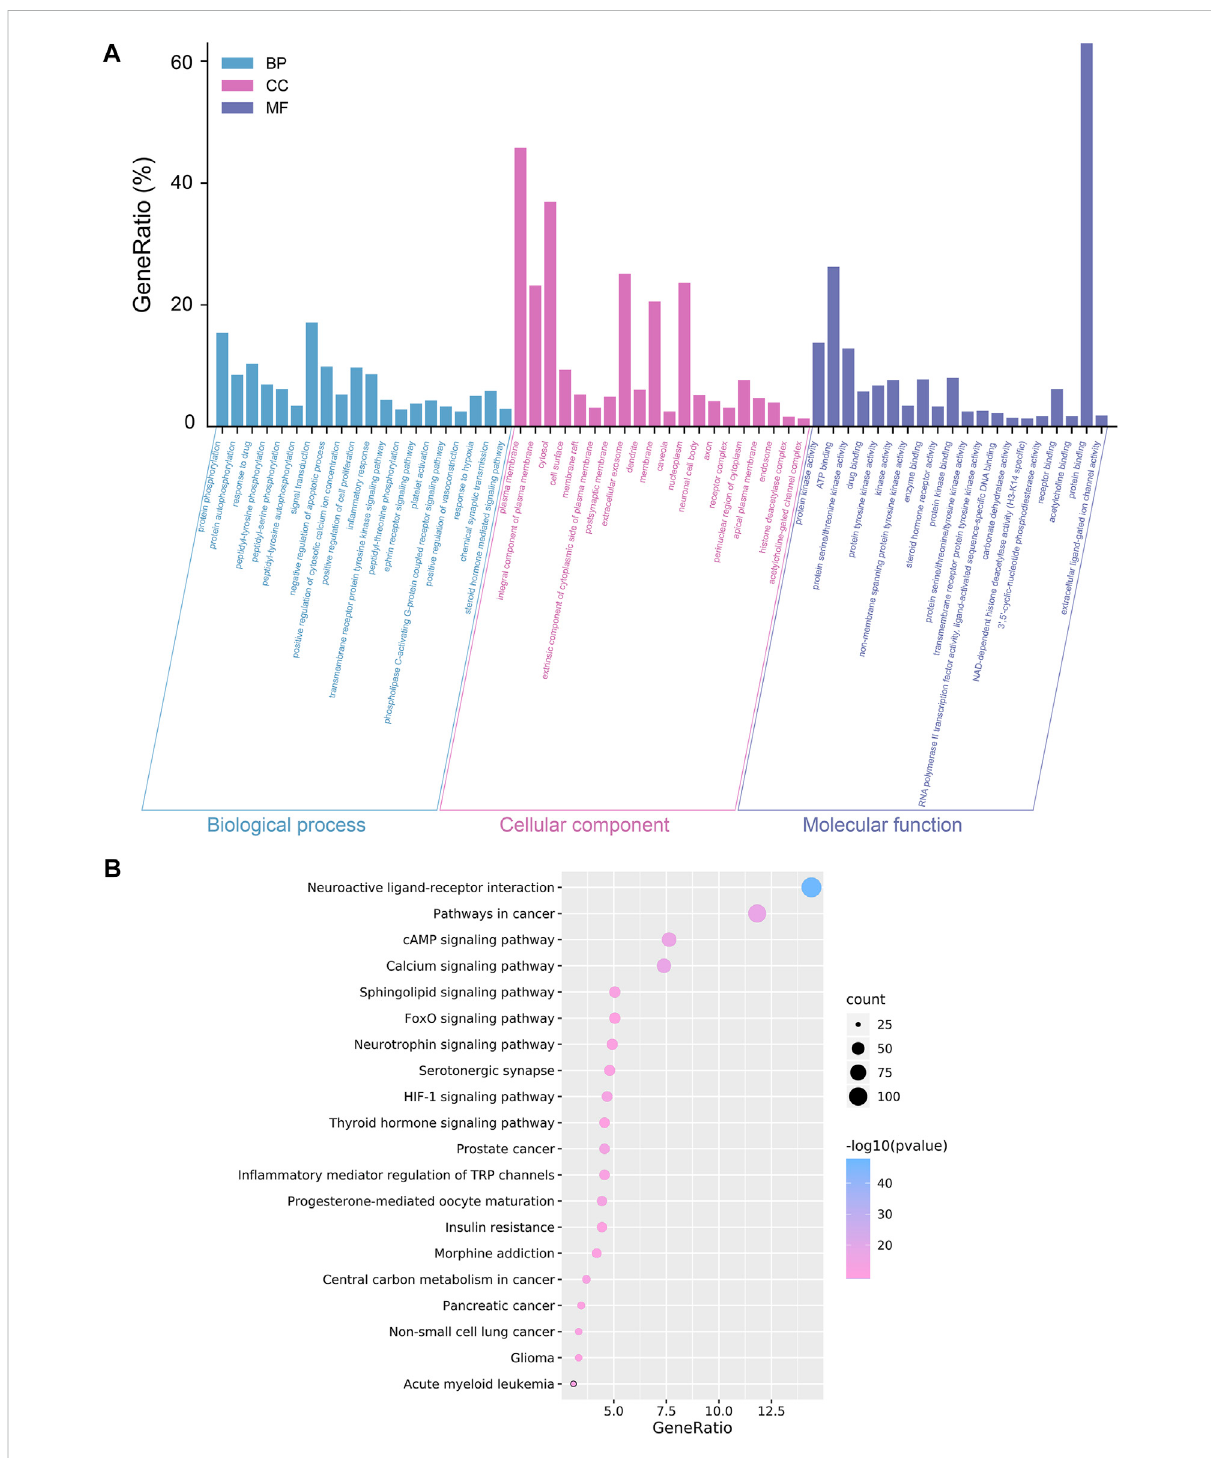
FIGURE 2 Analyses of GO and KEGG enrichment for CCMM targets ( p -value ≤ 0.05). (A) The top 20 GO enrichment terms include biological process, cellular component, and molecular function. The GeneRatio (%) of the top 20 most signi fi cant enrichments is shown in the bar graphs. (B) The top 20 KEGG pathways. The color grades re fl ect the various p -value thresholds, and the sizes of the dots indicate the number of targets associated with each